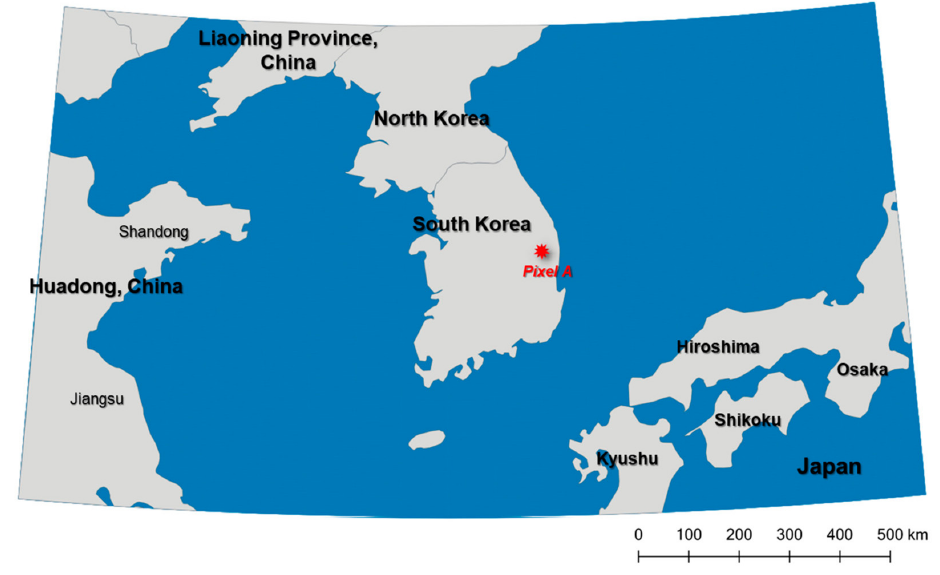
Figure 1. Location of the study